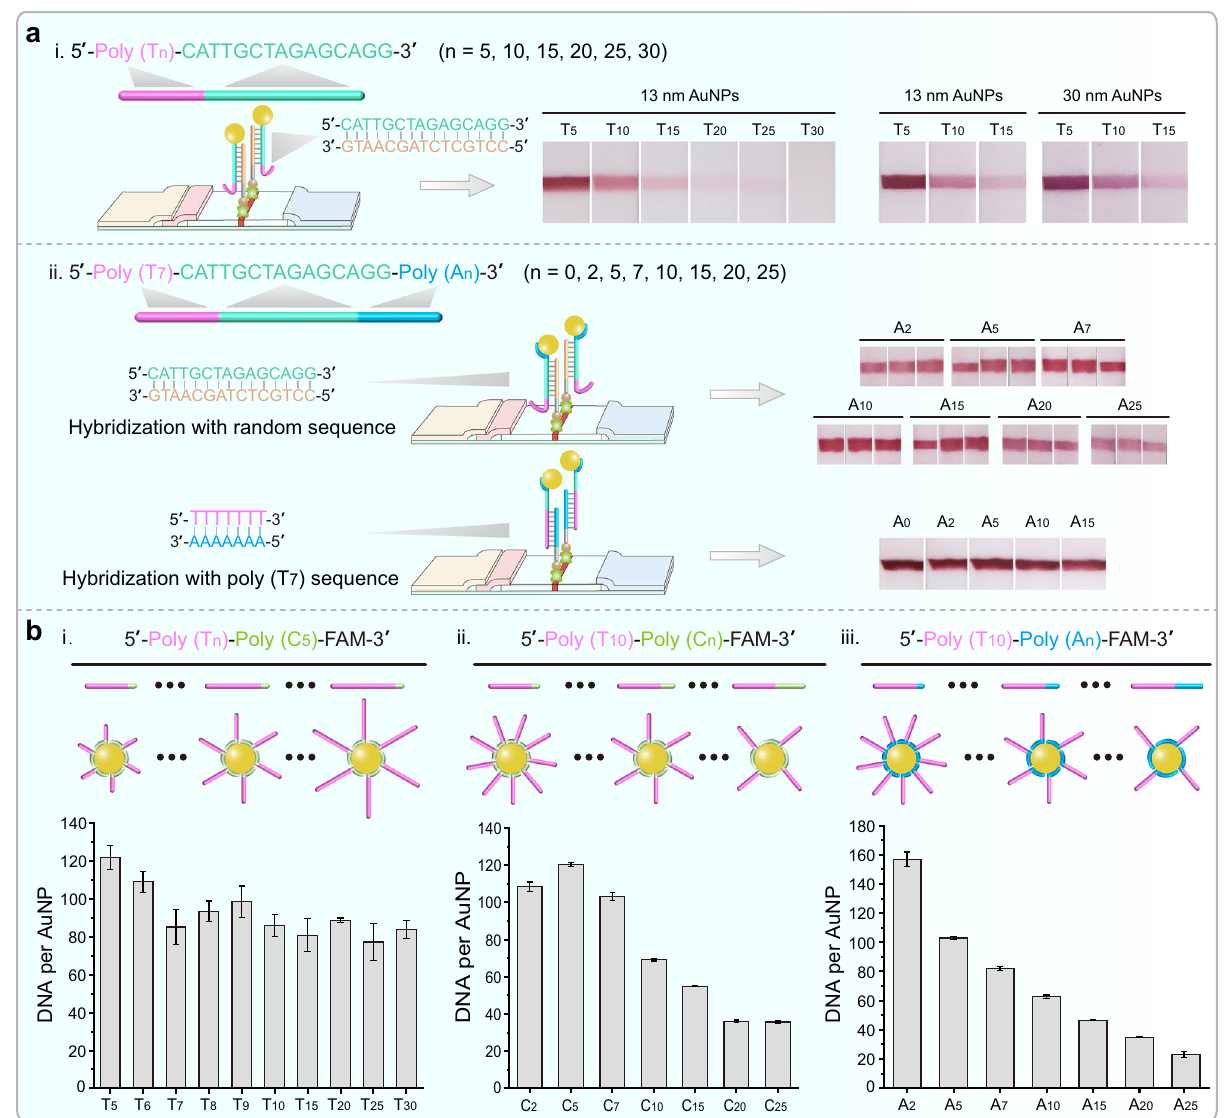
Fig. 4 Veri fi cation of poly (T) tag orientation in the SNA structure using test trip hybridization and loading counting experiments. a (i) Scheme showing the poly (T n )-tagged DNA probes are used for AuNPs labeling and the lateral fl ow hybridization device. A complementary DNA probe is pre- coated on the lateral fl ow device used for hybridization. 13 and 30 nm diameter AuNPs are used for labeling and subsequent hybridization experiments. (ii) DNA sequences with poly (T 7 ) and poly (A n ) tags at both terminals are used for AuNPs labeling and subsequent hybridization experiments. Two kinds of DNA probes are pre-coated on the lateral fl ow device for hybridizing with T 7 and random DNA region, respectively. Hybridization results are observed by the naked eyes. b Counting of the attached DNA number from three labeling situations. Three kinds of DNA probes including (i) Poly (T n )-Poly (C 5 ), (ii) Poly (T 10 )-Poly (C n ), and (iii) Poly (T 10 )-Poly (C 5 ), are used for labeling. FAM dye is modi fi ed at 3 ′ -terminal of these DNA sequences. Error bars = standard deviation ( n = under heating (Fig. 5a and Supplementary Fig. 15). As observed, is almost unchanged with varied low-af fi nity poly (T) lengths but maintains fi xed high-af fi nity poly (C 5 ) tag (Fig. 4b(i)). under both 90 and 150 °C, the AuNPs aggregated after the Keep the poly (T 10 ) tag fi xed, while increasing the length of poly centrifugation-resuspension treatment, which show that heating (C) and poly (A) tags, attached DNA is gradually reduced process cannot mediate ef fi cient DNA-AuNP conjugation (Fig. 4b(ii), (iii)). (Fig. 5a, top panel and Supplementary Fig. 15). Conversely, all poly (T)-tagged DNA sequences could be ef fi ciently attached to AuNPs using heating-dry method (Fig. 5a, below panel). In Mechanism description . It is fascinating that poly (T/U)-tagged another test, when AuNPs solution were mixed with six kinds of DNA/RNA can be loaded on the AuNPs surface at high density DNAs and dried at lower temperatures (30 and 90 °C), feasible by simply heating-dry treatment. Previous study has shown that labeling was achieved although with nonuniform labeling ef fi - heating could drive DNA to be adsorbed onto AuNPs or ciency (Supplementary Fig. 15). The nonuniform labeling ef fi - graphene 43,44 . To understand whether this labeling is only ciency may be due to the structural in fl uence of some DNA induced by heating, some random DNA sequences with poly sequences, which in turn affects the stability, density, and activity (A 10 /T 10 /C 10 /G 10 ) tags at 5 ′ -terminal were mixed with AuNPs